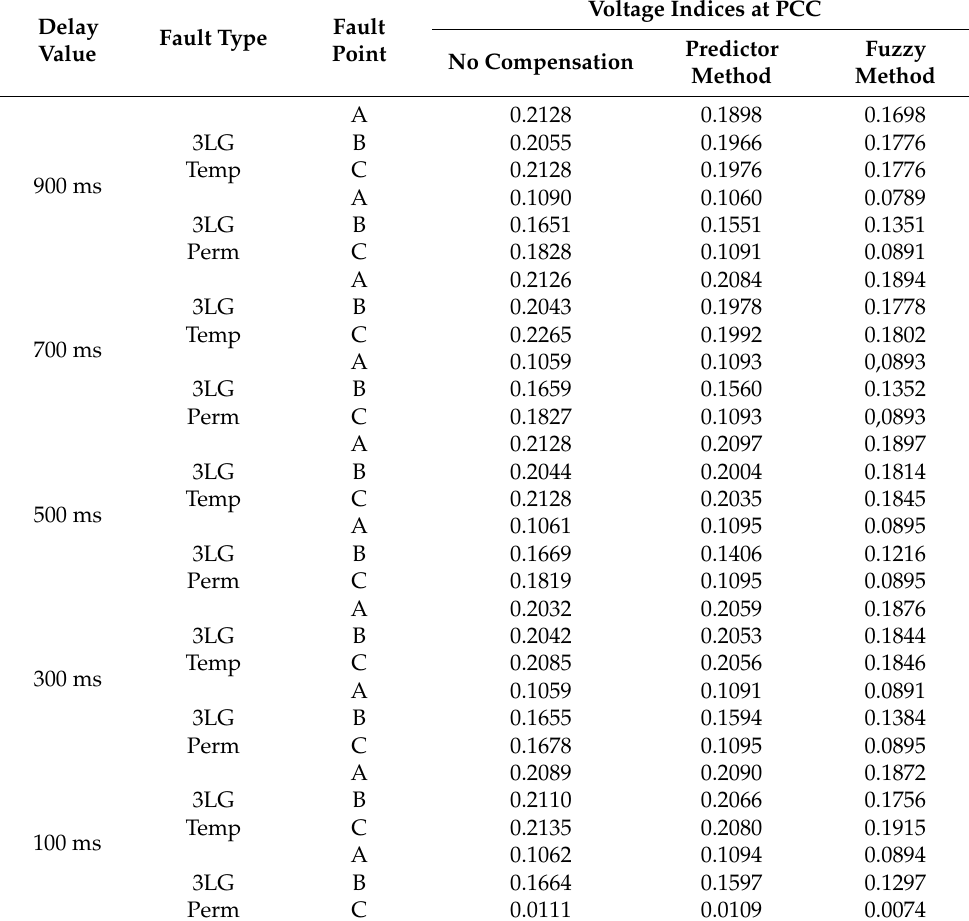
Figure 17. Inter-area voltage for 3LG temporary fault at location B.